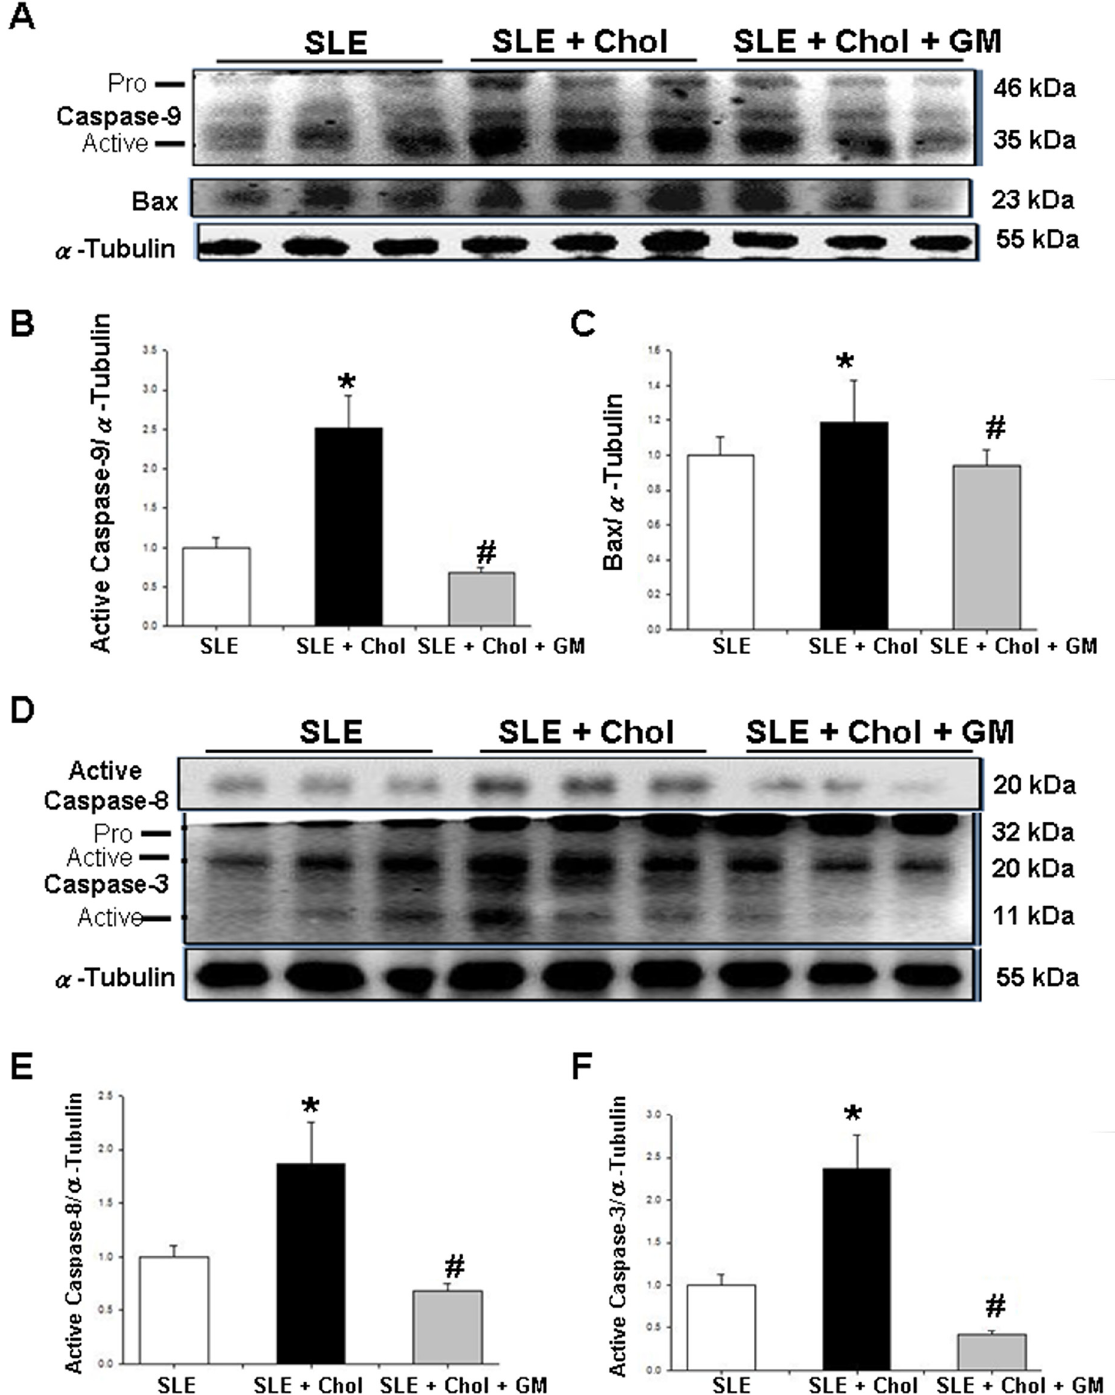
Fig 3. Variations in mitochondrial-dependent components in left ventricular tissues of NZB/W F1 mice that were fed with different dietary supplements. (A) Expressions of active caspase-9 and Bax in left ventricles of hearts of NZB/W F1 mice fed with different supplements, as measured by Western blotting analysis. α -Tubulin was used as an internal control. Bars represent quantities of (B) active caspase-9 (35kDa) and (C) Bax relative to that of α -Tubulin. (D) Expressions of active caspase-8 and caspase-3 in left ventricles of hearts from NZB/W F1 mice fed with different supplements, as measured by Western blotting analysis. α -Tubulin was used an internal control. Bars represent quantities of (E) active caspase-8 and (F) active caspase-3 (20kDa) proteins relative to quantity of α -Tubulin, respectively. * and # indicate significant differences relative to SLE or SLE + cholesterol groups, respectively. Similar results were obtained in triplicate experiments. SLE: systemic lupus erythematosus; Chol: cholesterol; GM: Gentiana macrophylla